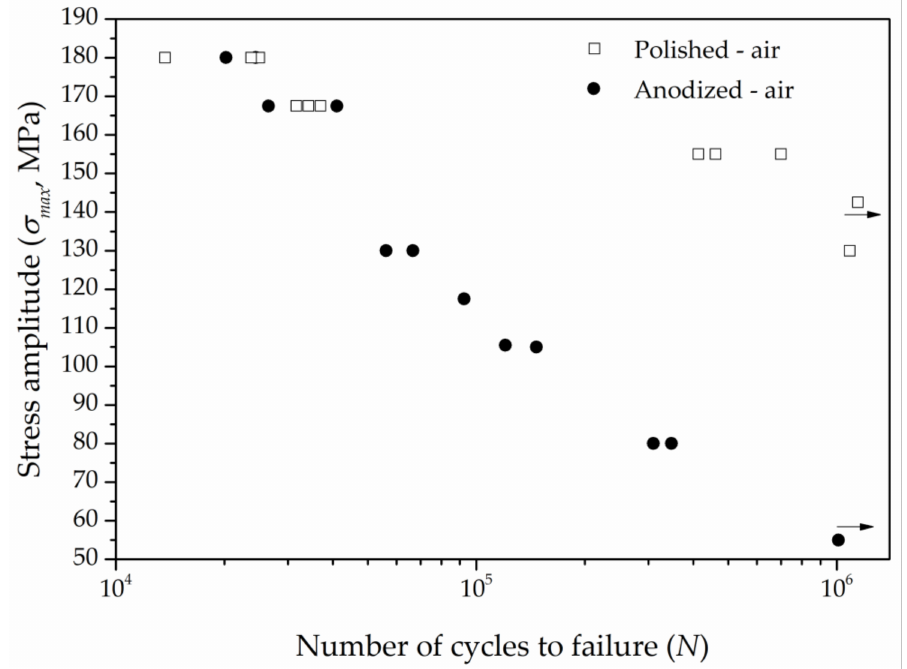
Figure 7. S- N curves for the polished and anodized AZ31B alloy specimens in